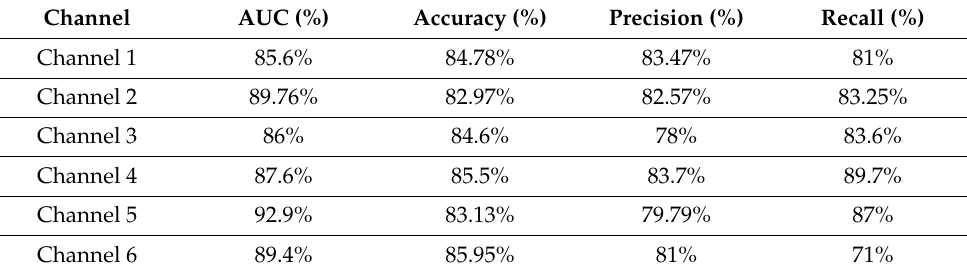
Table 3. Accuracy, area under curve (AUC), precision and recall results for model 1, 30 s epochs.